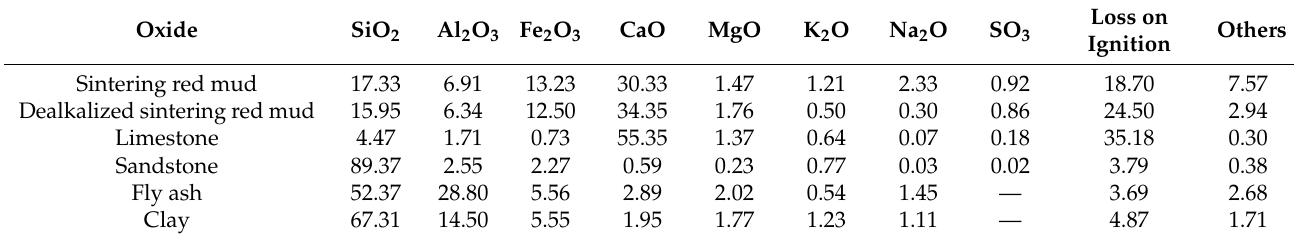
Table 1. Chemical composition of raw materials